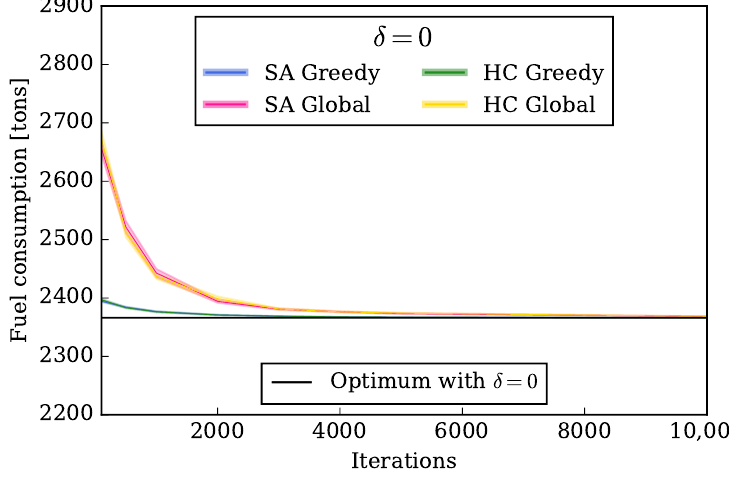
Figure 6. Total fuel consumption for the different techniques and δ =